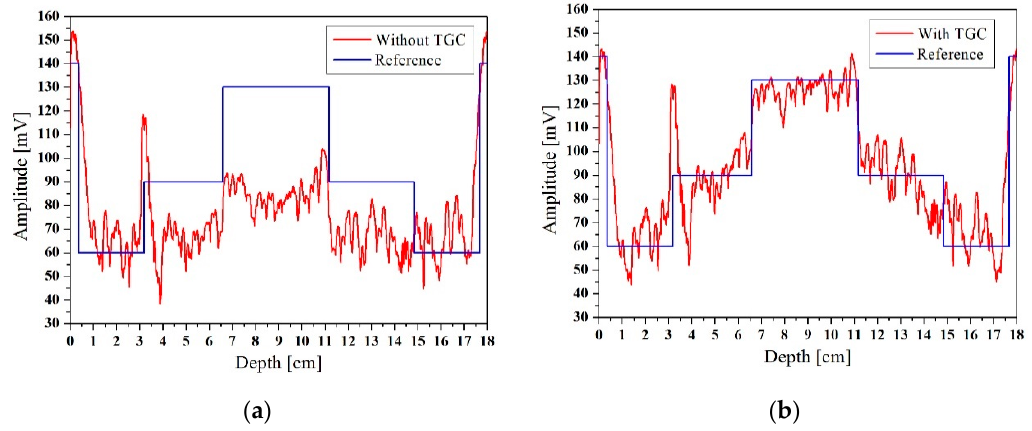
Figure 14. Cross-sections of the horizontal ultrasound tomography image at y = 9 cm: ( a ) without TGC, ( b ) with adaptive TGC. Table 1. Peak signal to noise ratio (PSNR) and root-mean-square error (RMSE) run for the profiles. Ultrasound Tomography